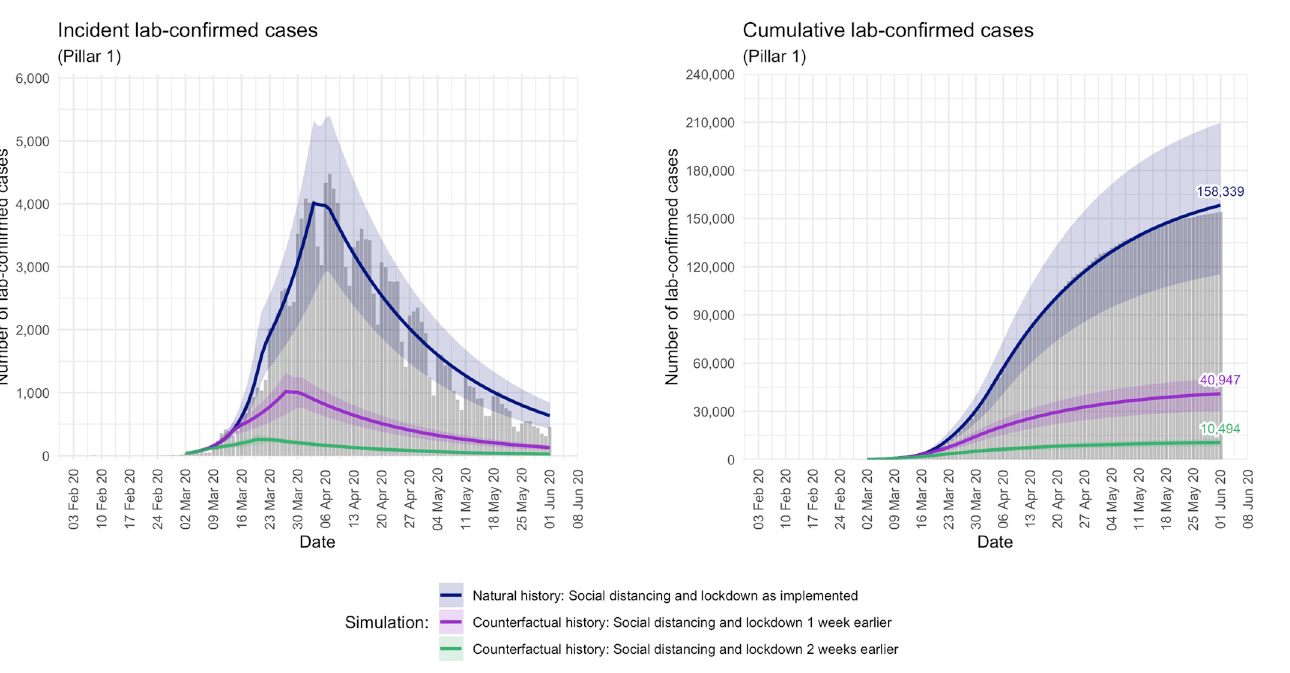
Fig 2. Incident and cumulative COVID-19 cases in England. Incident and cumulative Pillar 1 lab-confirmed cases of COVID-19 from 3 March to 1 June, under each of the three scenarios modelled. Under the natural history, social distancing and lockdown measures were implemented on 17 and 24 March, respectively. Grey bars represent daily number of observed incident cases. Blue lines represent mean number of incident cases across all 100,000 simulation runs, including the 95% simulation